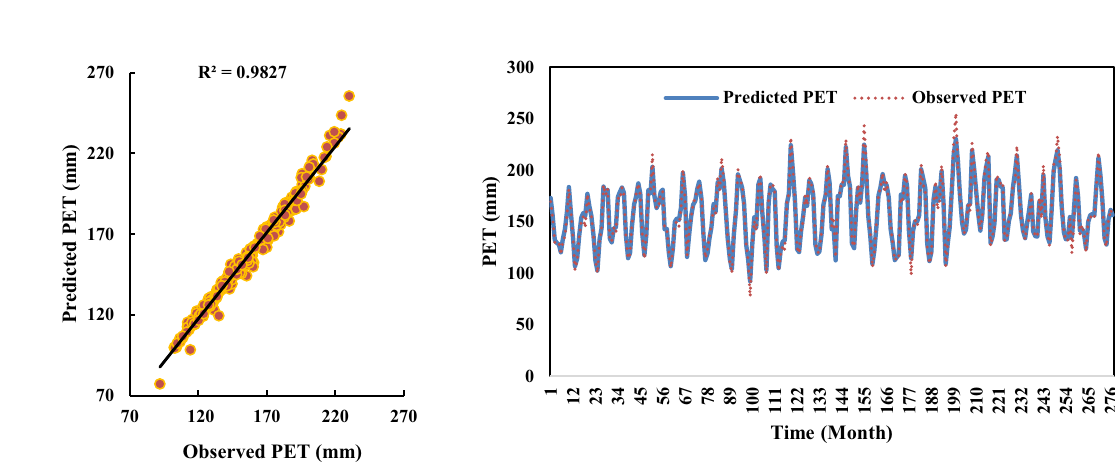
Fig. 4 Summary of agreement between observed and predicted PET at calibration phase based on scatter and time series